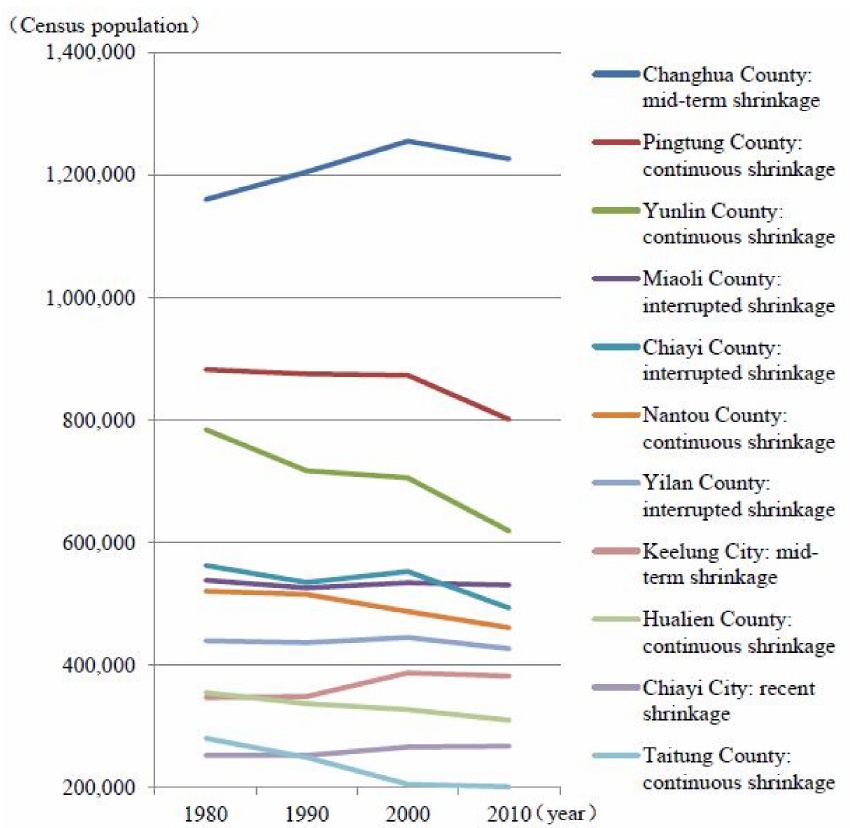
Figure 5. Time trajectory of shrinking counties based on the census